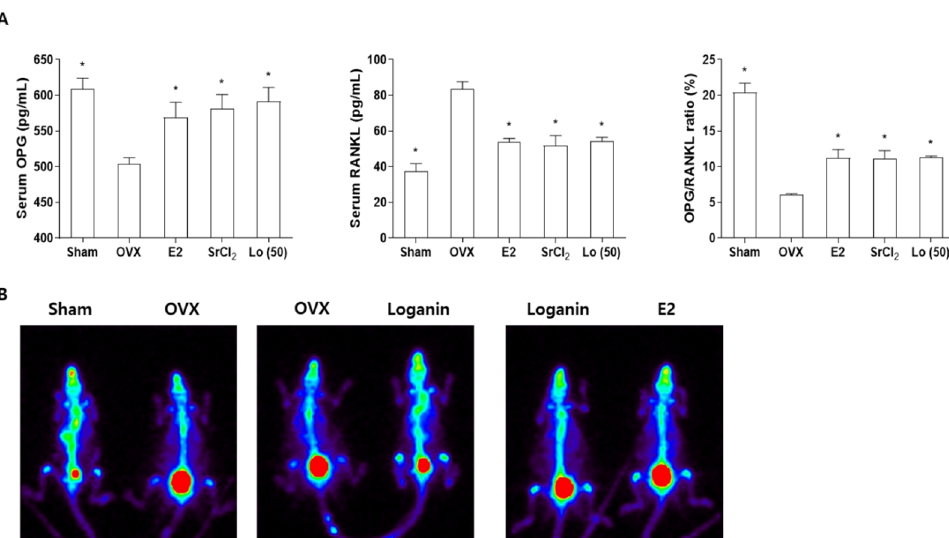
Figure 7. Effects of loganin on ovariectomy (OVX)-induced parameters in the serum and bone of mice. Sham-operated or ovariectomized (OVX) ddY mice were administered 17β-estradiol (E2, 0.03 μg), strontium chloride (SrCl 2 , 10 mg/kg/day), or loganin (50 mg/kg/day) for 12 weeks. ( A ) Serum levels of osteoprotegerin (OPG) and receptor activator of nuclear factor-κB ligand (RANKL) were examined using a MILLIPLEX ® multiplex assay. ( B ) Bone scintigraphy images using technetium Tc-99m HDP ( 99m Tc-HDP) were obtained by Inveon SPECT scan. * p < 0.05 vs. OVX (one-way ANOVA).